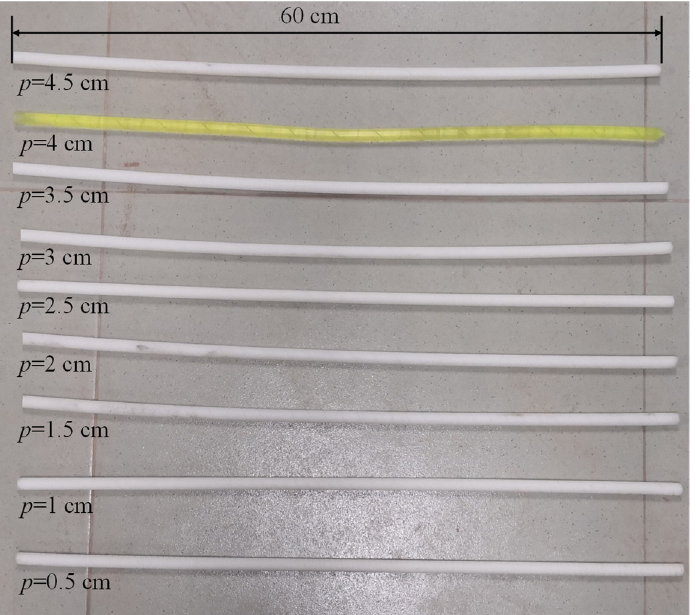
Figure 8. Highly elastic rubber rods of different pitches with a diameter of 10 mm and a length of 60 cm.